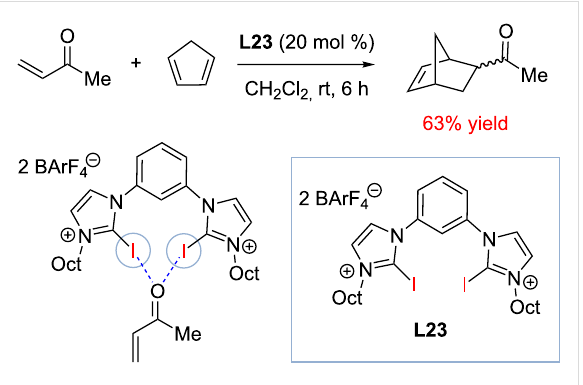
catalyst. The binding properties of L19–L21 toward halides in the solid state, in solution, and in the (calculated) gas